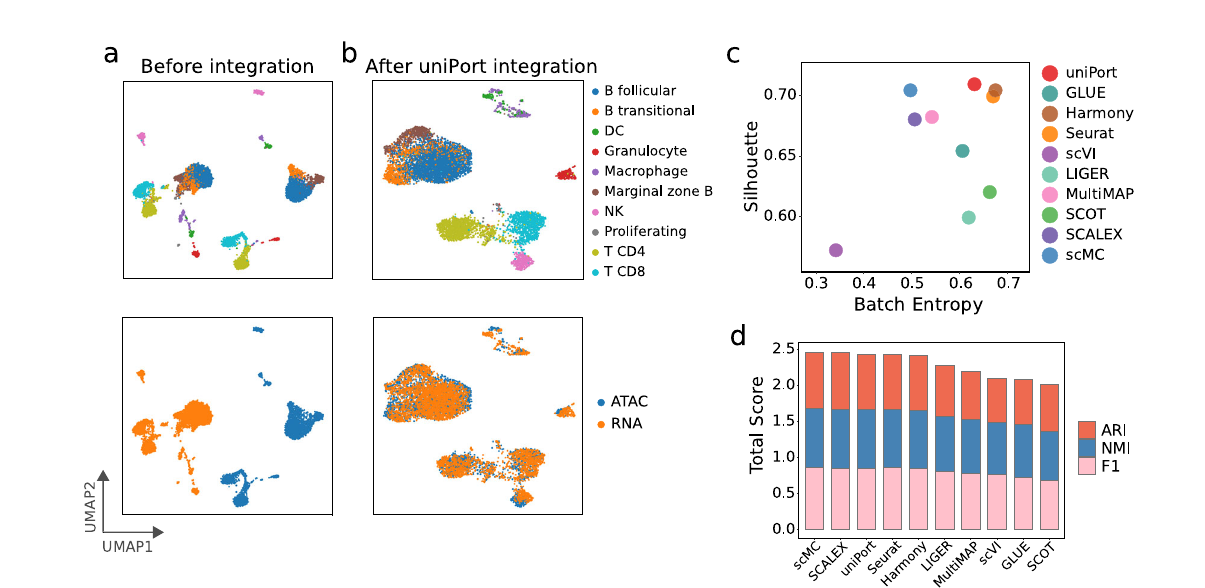
c Comparison of total scores of ARI, NMI and F1 of different methods. d Comparison of Batch Entropy scores and Silhouette coef fi cients of different methods. e Comparison of average FOSCTTM of different